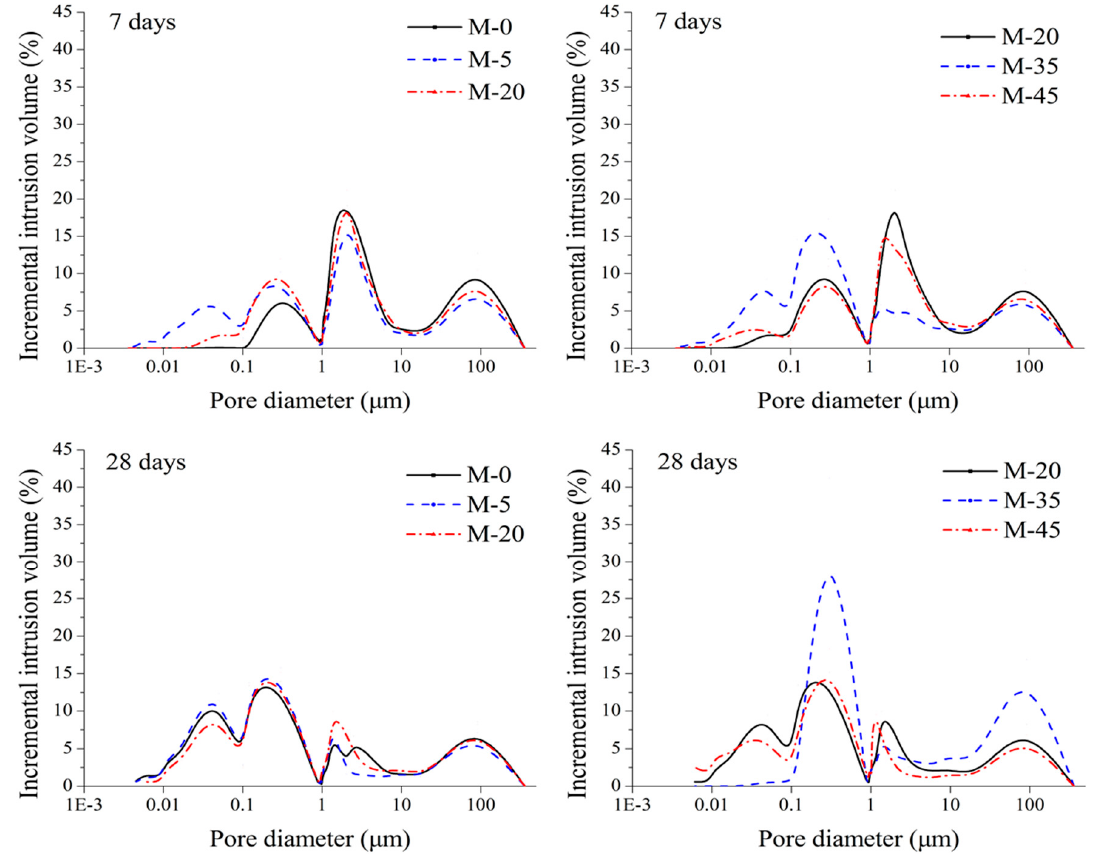
Figure 4. Pore size distributions (PSDs) obtained for the prepared mortar specimens after 7 and 28 days of aging.